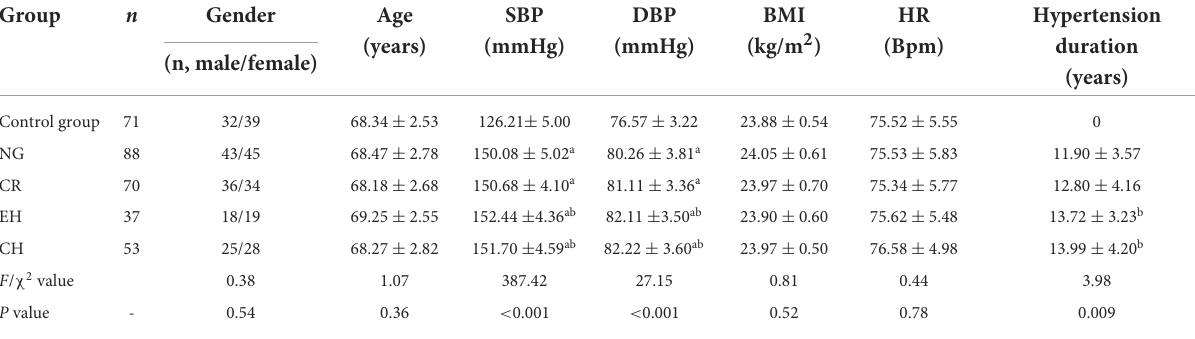
TABLE 1 Comparison of general data ( x ± s).